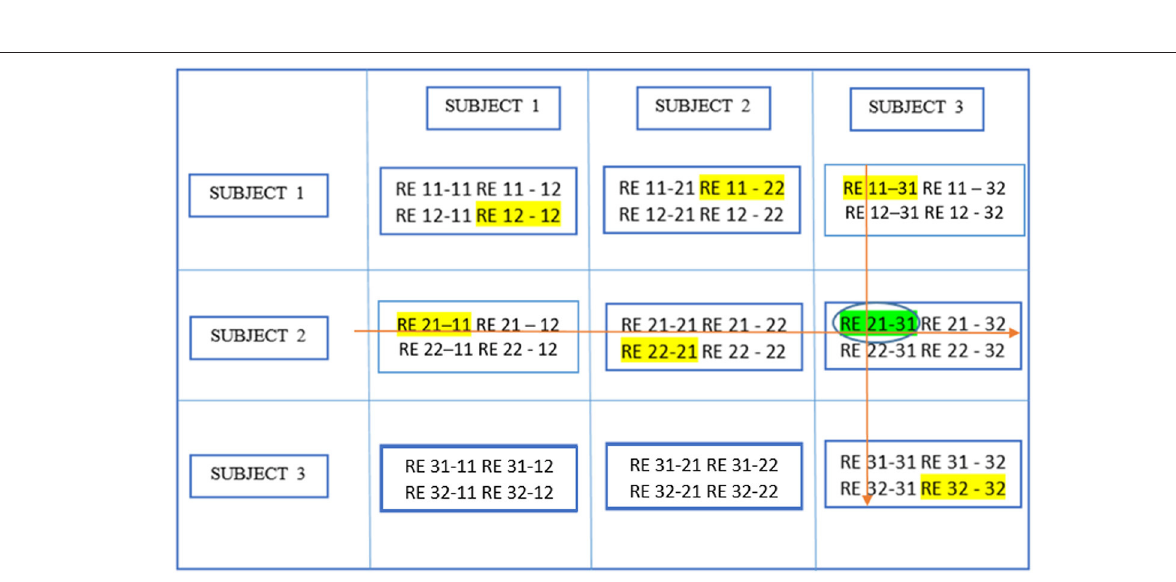
FIGURE 6 | Determine block-wise maxima with highlighting in each block. Global maximum in this figure has a circle around it in addition and has been shown in an earlier figure as well.